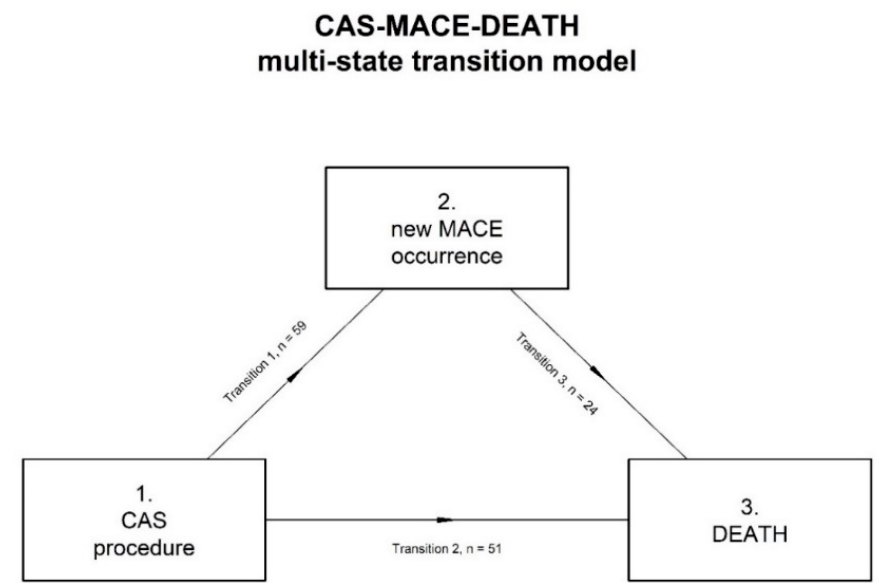
Figure 1. Multi-state transition model (illness-death) used to analyze sample data. Arrows express the transition from one state to another. Transitions are numbered from 1 to 3 and the number of patients in each transition is indicated.